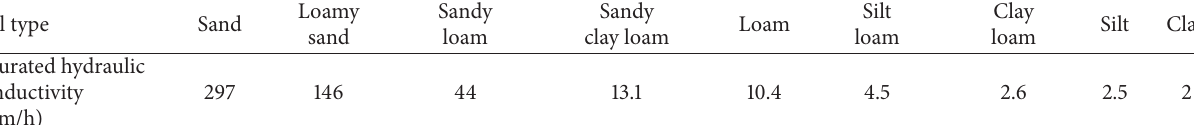
Table 4: The saturated hydraulic conductivity of soils included in the soil catalog of the HYDRUS-1D model.